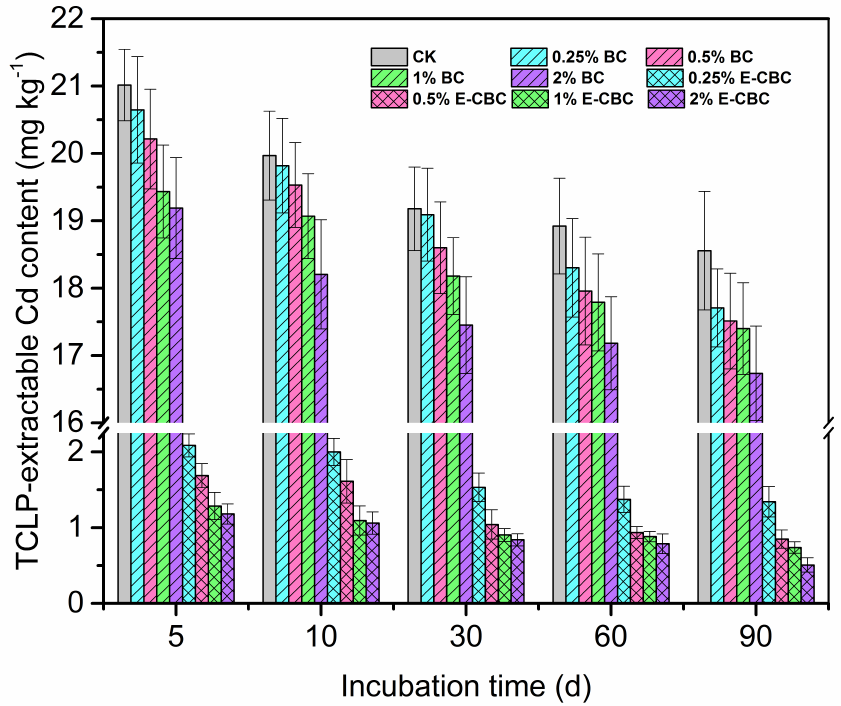
Figure 5. Effects of BC and E–CBC on the leachability of Cd in